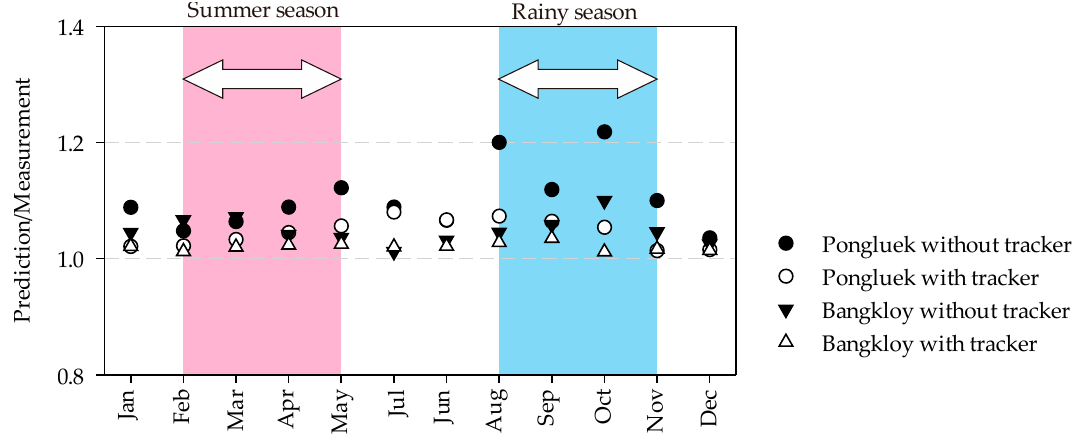
Figure 19. Water flow for two villages with/without a solar tracking system.